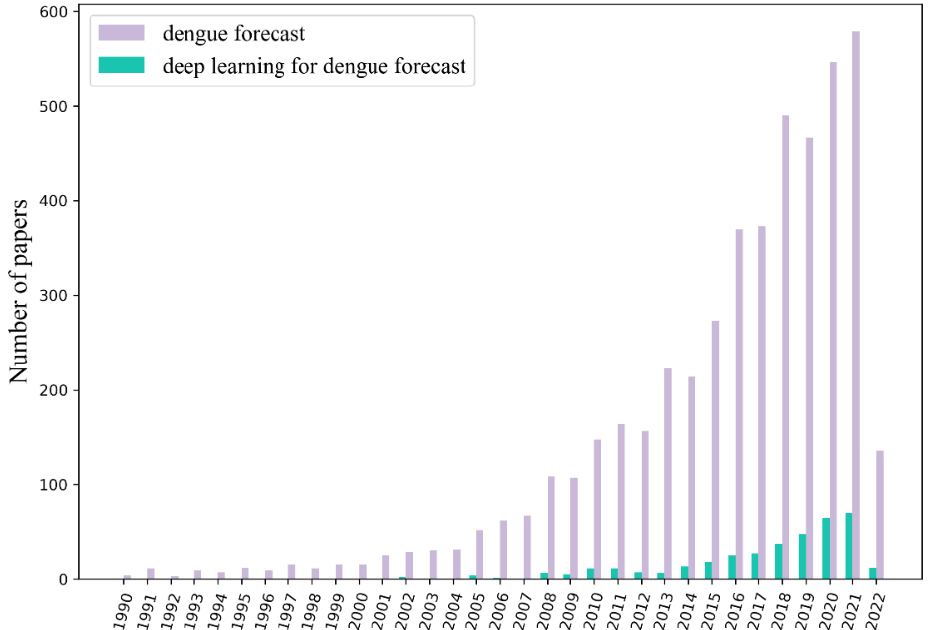
Figure 1. Histogram of publication years of the studies associated with dengue risk forecasting and the application of deep learning in dengue risk forecasting from 1990 to 2022. The two categories of literature records were collected using “dengue AND (predict* OR forecast*)” and “(deep learning OR neural net-work) AND (dengue AND (predict* OR forecast*))” in the field of title and abstract in Web of Science, Science Direct, MEDLINE (PubMed), Scopus, ACM digital library, and IEEE Xplore.